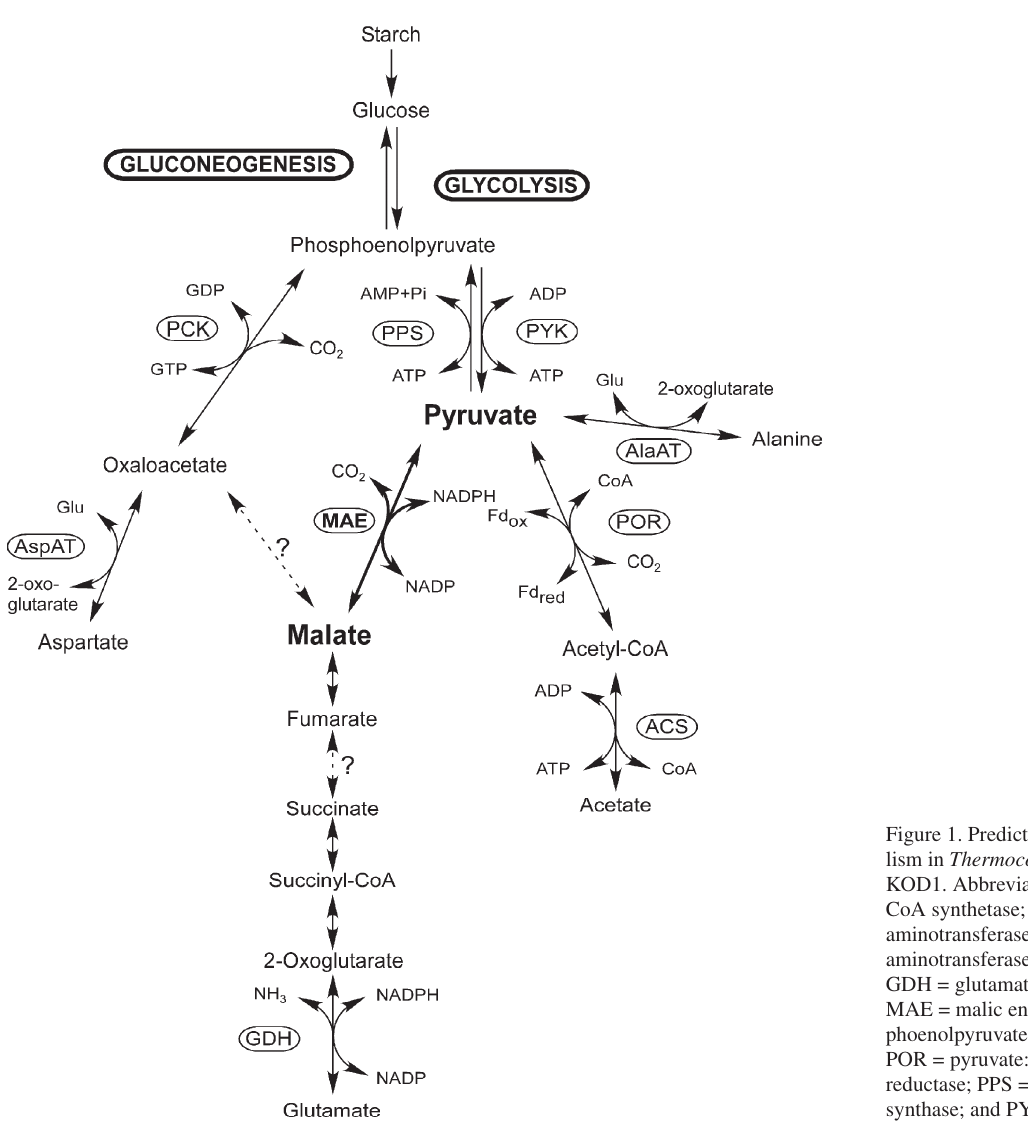
Figure 1. Predicted pyruvate metabo- lism in Thermococcus kodakaraensis KOD1. Abbreviations: ACS = acetyl- CoA synthetase; AlaAT = alanine aminotransferase; AspAT = aspartate aminotransferase; Fd = ferredoxin; GDH = glutamate dehydrogenase; MAE = malic enzyme; PCK = phos- phoenolpyruvate carboxykinase; POR = pyruvate:ferredoxin oxido- reductase; PPS = phosphoenolpyruvate synthase; and PYK = pyruvate